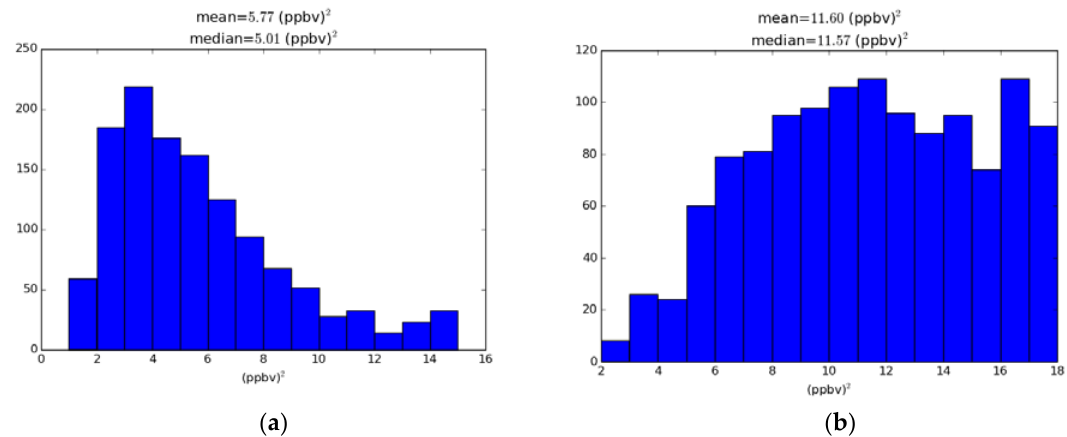
Figure 5. Distribution (histogram) of the ozone analysis error variance at the active observation locations. ( a ) First analysis experiment O 3 iter 0 (no optimization) on the left panel; ( b ) Optimal analysis case O 3 iter 1 . Note that the scales are different between the left and right panels.